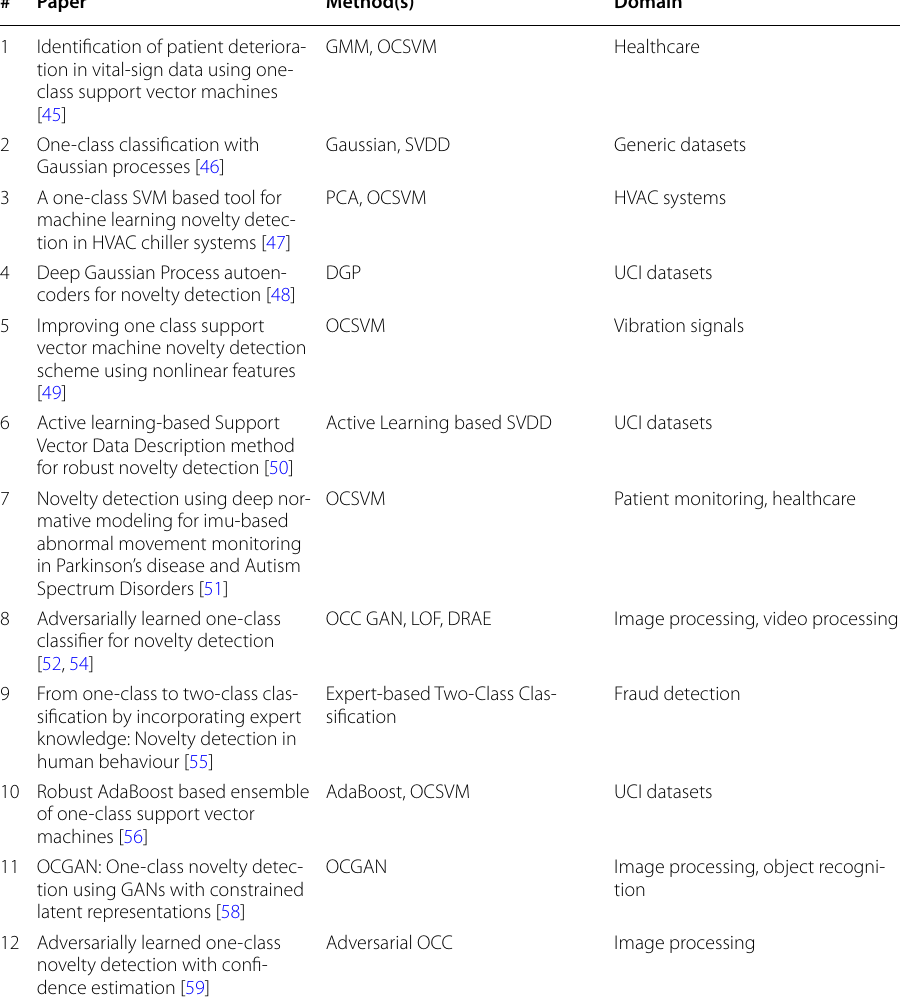
Table 2 Surveyed works on novelty detection and